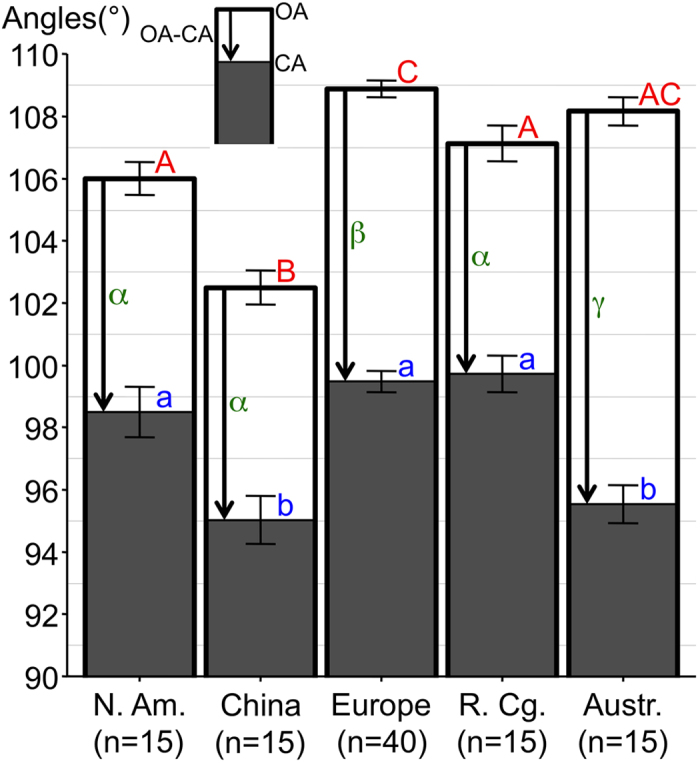
Histogram of orbital angle values (mean + /– SEM) in different modern human populations.The columns filled with dark-grey and limited by a thin line correspond to the convergence angle (CA). White columns limited by a thick line correspond to the opening angle (OA). The difference between OA and CA (OA-CA) is represented by an arrow. Statistically significant differences (p < 0.05) for OA, CA and OA-CA among the human populations were noted using red upper case letters, blue lower case letters and green Greek letters respectively. For the OA, there are significant differences between group A (North America and Republic of the Congo) and group C (Europe); group A and group B (China); group AC (Australia) and group B. For the CA, there are significant differences between group a (North America, Europe and Republic of the Congo) and group b (China and Australia). For the OA-CA, there are significant differences between group α (North America, China and Republic of the Congo) and group β (Europe); group α and group γ (Australia); group β and γ. Abbreviations used: N. Am. = North America; R. Cg. = Republic of the Congo; Austr. = Australia.